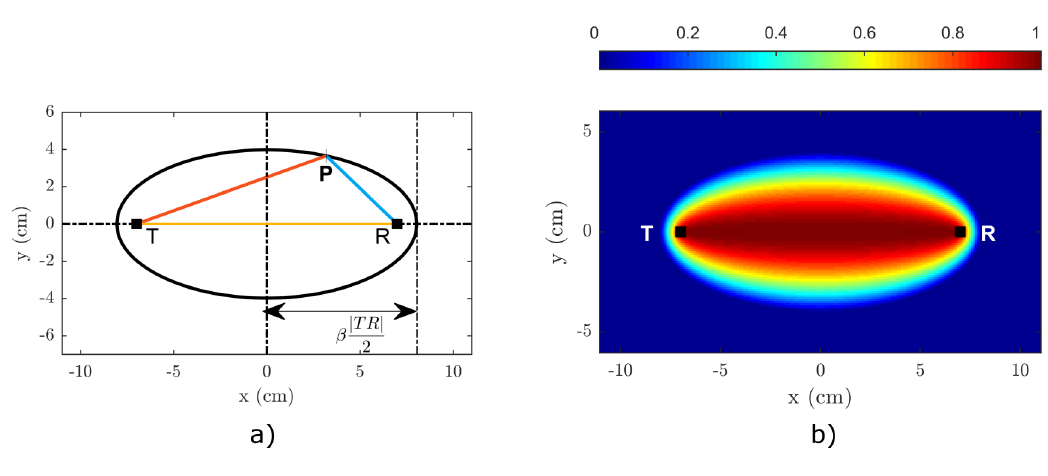
Figure 2. Geometrical interpretation of the ( a ) R ij ( x , y ) function and ( b ) s ij ( x , y )